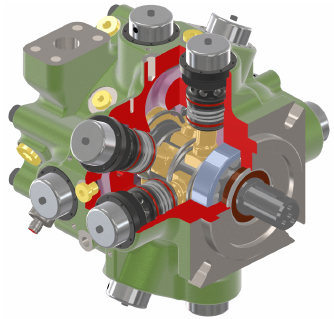
Figure 10. E-dyn 96 digital displacement hydraulic pump, reprinted with kind permission from Artemis Intelligent Power Ltd., Loanhead, Scotland (UK).